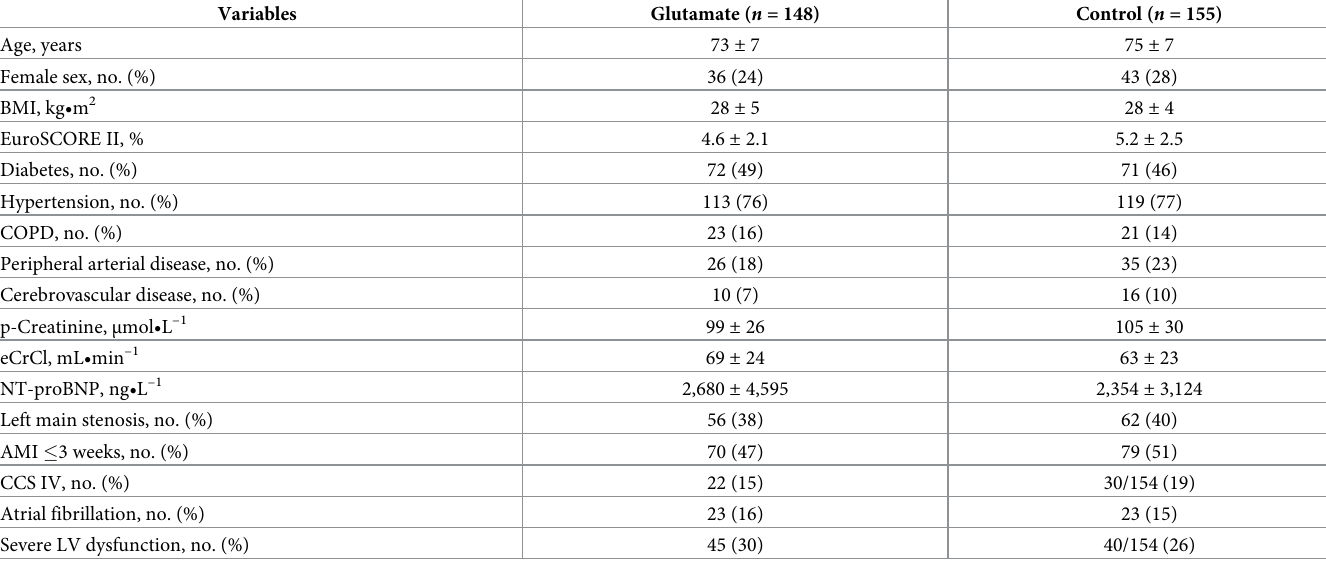
Table 1. Preoperative characteristics of the glutamate group and the control group (saline). Variables Glutamate ( n = 148) Control ( n = 155) 73 ± 7 75 ± 7 36